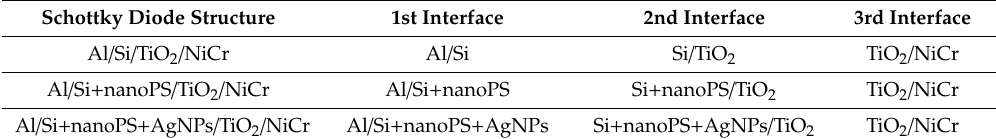
Table 1. Summary of the interfaces for the three Schottky junction diodes under analysis.